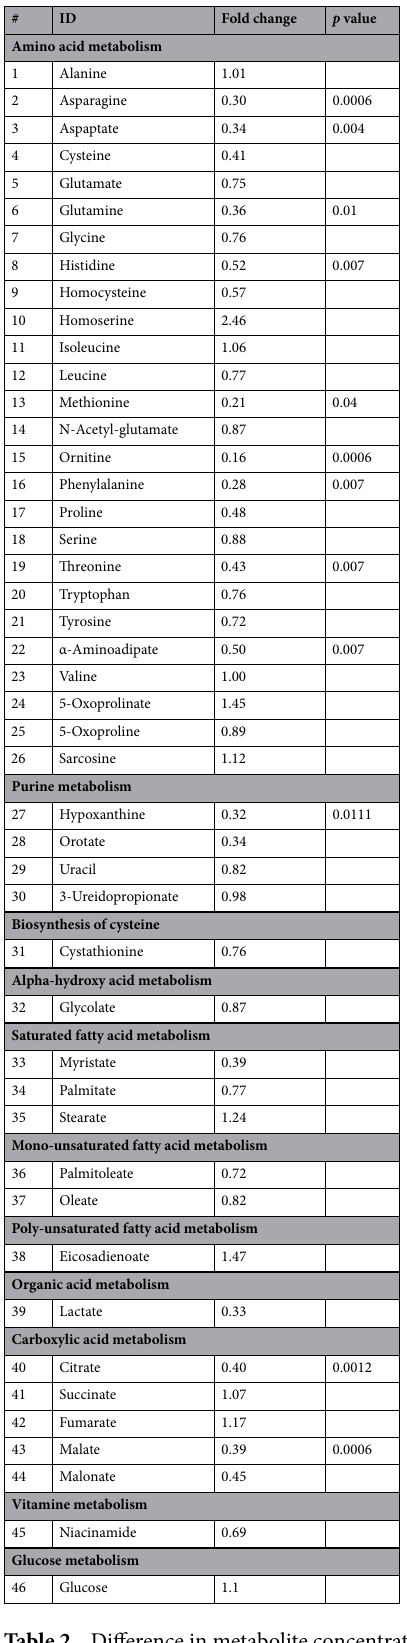
Table 2. Difference in metabolite concentrations between WT and mtl1Δ